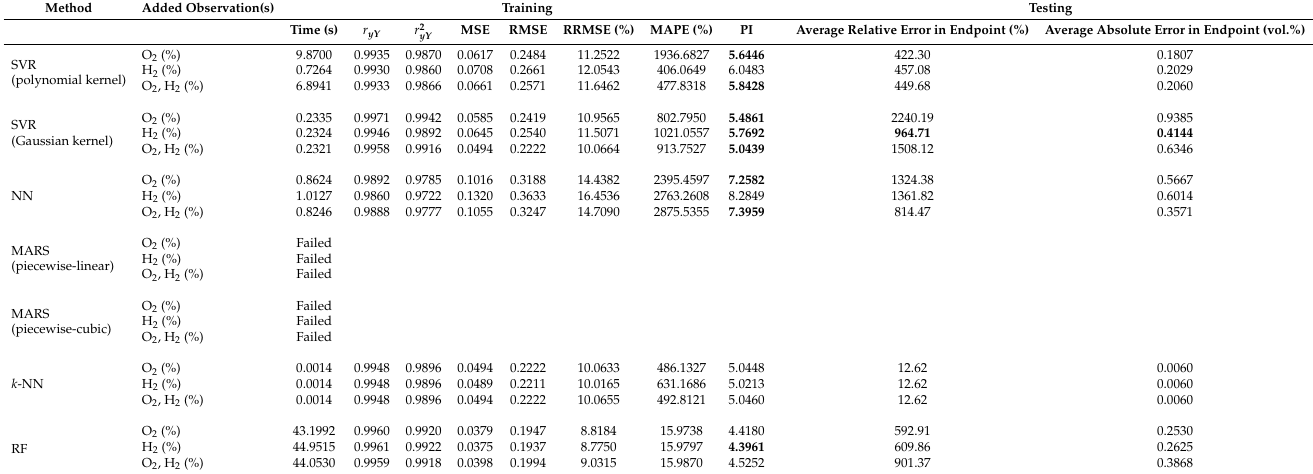
Table 20. Performance of machine learning and carbon prediction based on dynamic data (concentra- tion of O 2 and H 2 added as supplementary